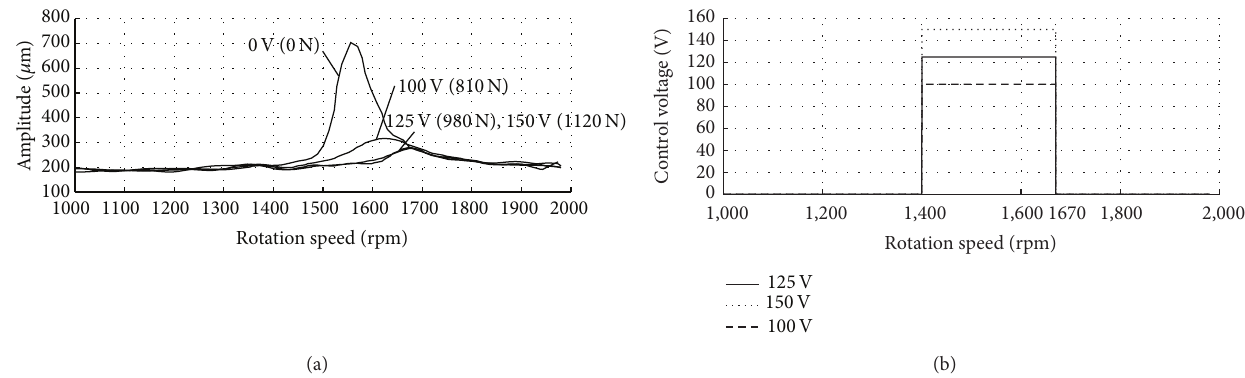
Figure 15: The Bode curves of the rotor system with various damping force applied just during the critical speed region (1400 rpm ∼ 1670rpm) (CH1).